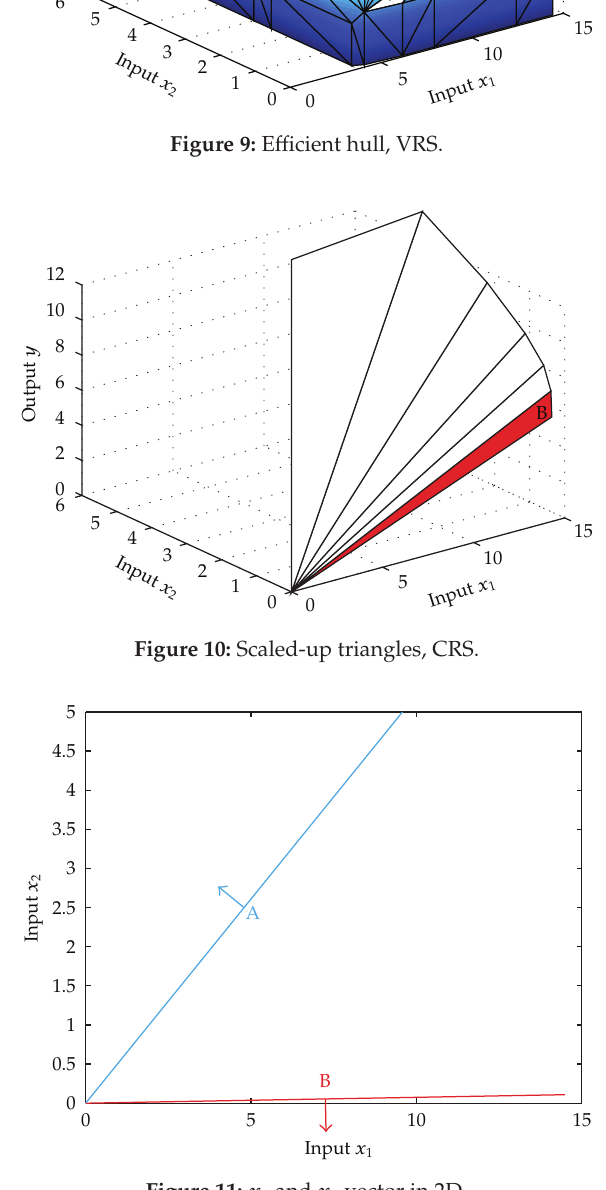
Figure 11: x 1 and x 2 vector in